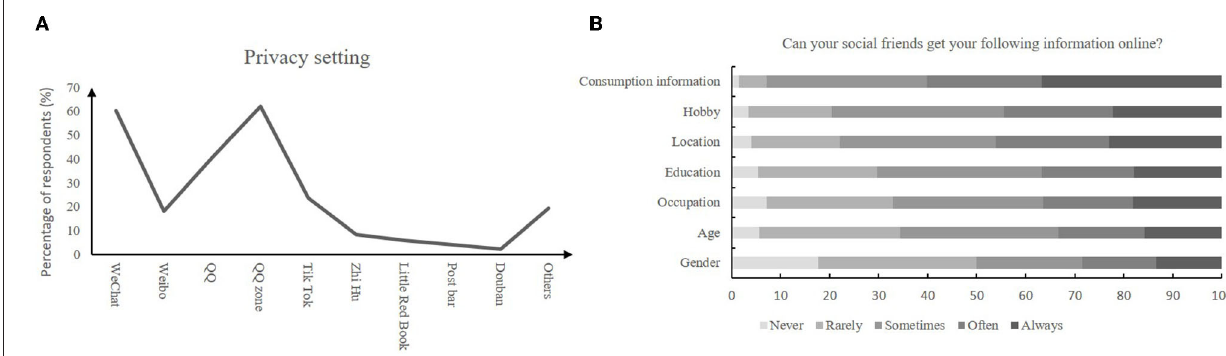
FIGURE 1 | Privacy information protection. (A) Privacy setting; (B) Information viewed by others.